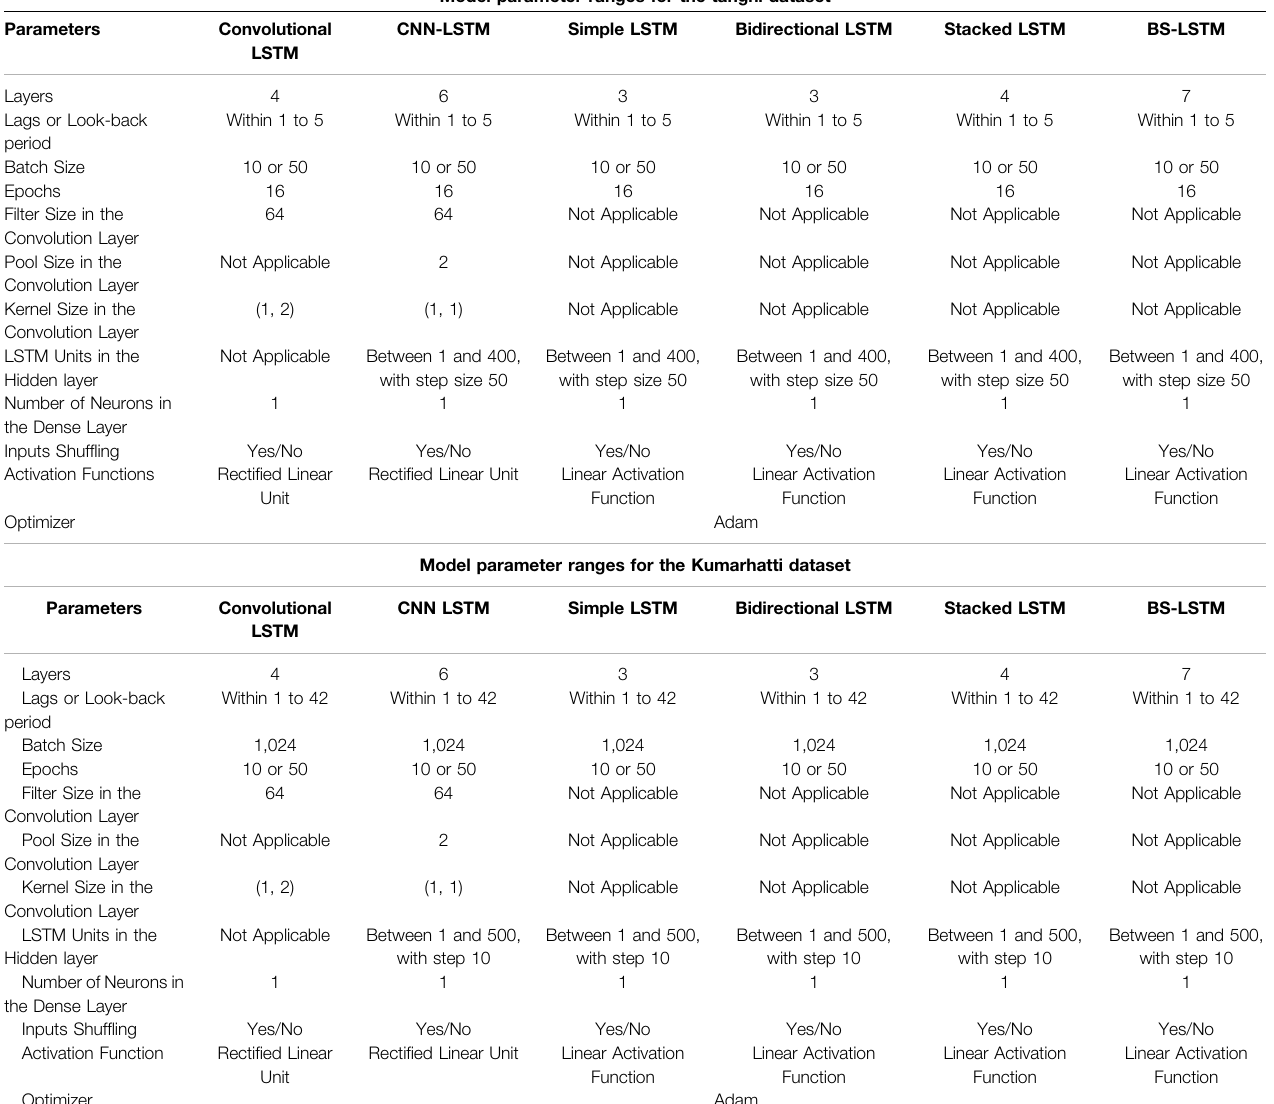
TABLE 2 | Parameter optimization of different LSTM models.